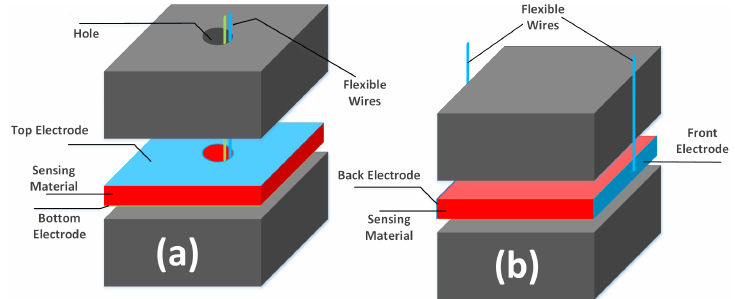
Figure 3. A Few More Embodiments [33,34]: ( a ) Using a Hole in the Top and Sensory Layers ( b ) Using Sides of the Sensing